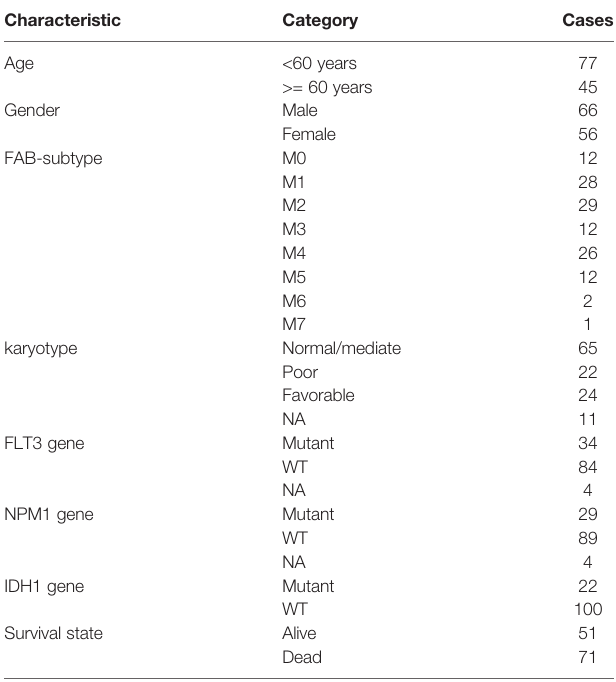
TABLE 1 | Clinical characteristics of 122 AML patients enrolled from the TCGA database for survival analysis.